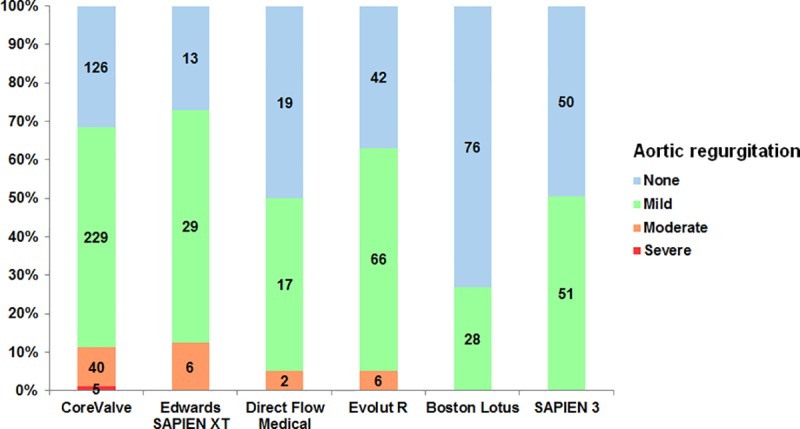
Distribution of pAR severity according to THV type.The bar diagram shows that 326/805 (40.5%) of the patients had no relevant pAR, 420/805 (52.2%) trace or mild pAR, whereas 59/805 (7.3%) of the patients suffered from moderate/severe pAR in TTE post TAVI.